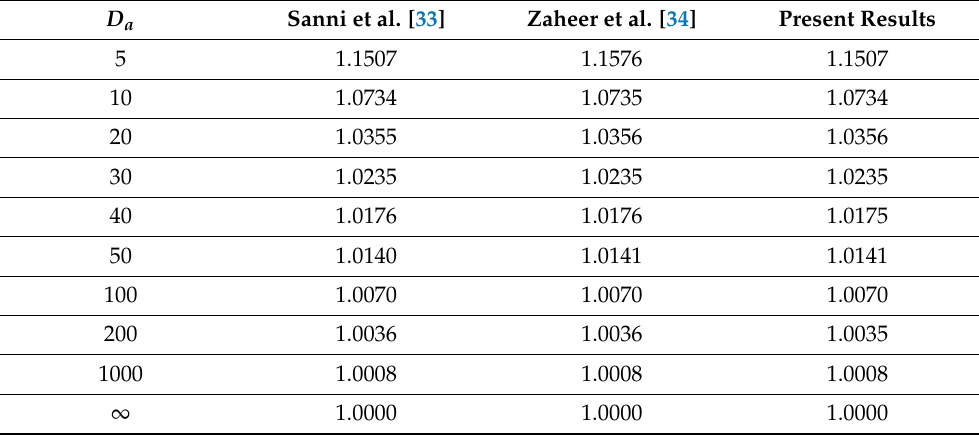
Table 2. Evaluation of the present outcomes of the skin friction for the distinct value of the radius curvature parameter D a when Σ a = γ a = f wa =